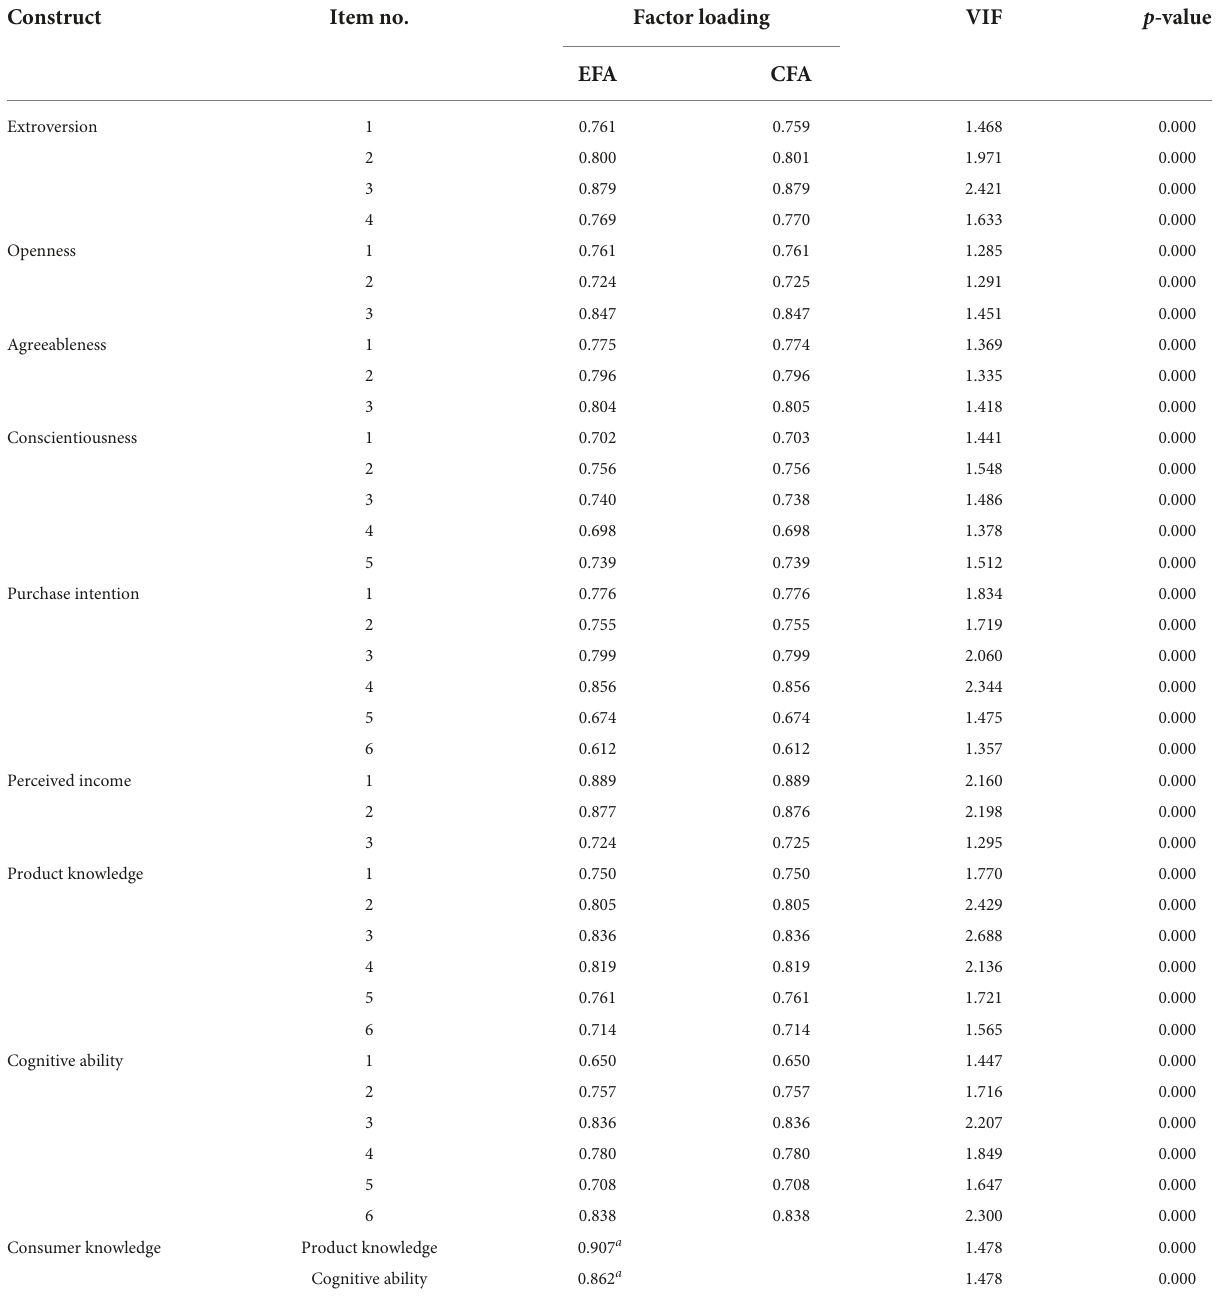
TABLE 1 EFA and CFA